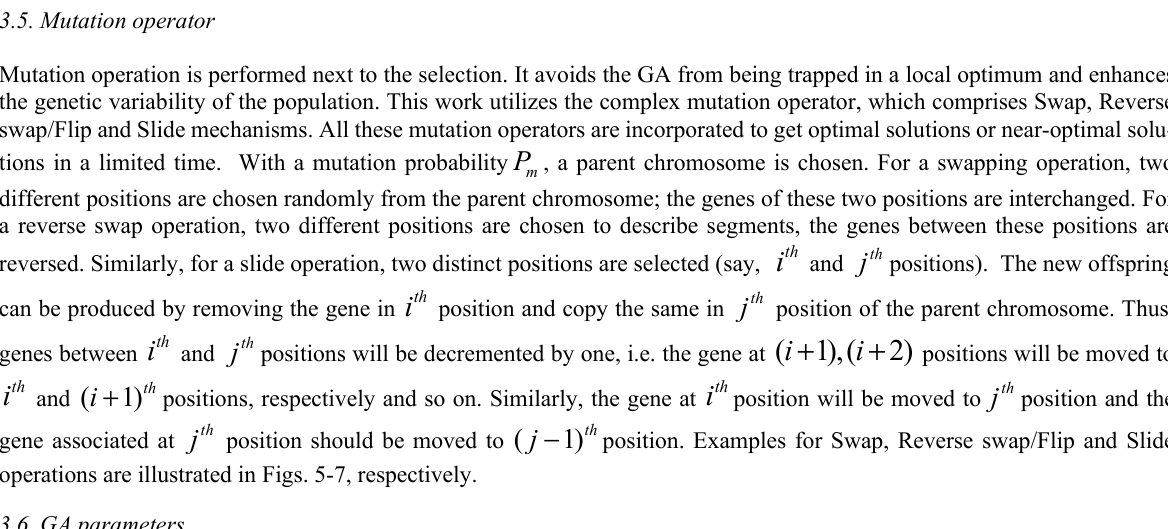
Fig. 5. Swap Operator